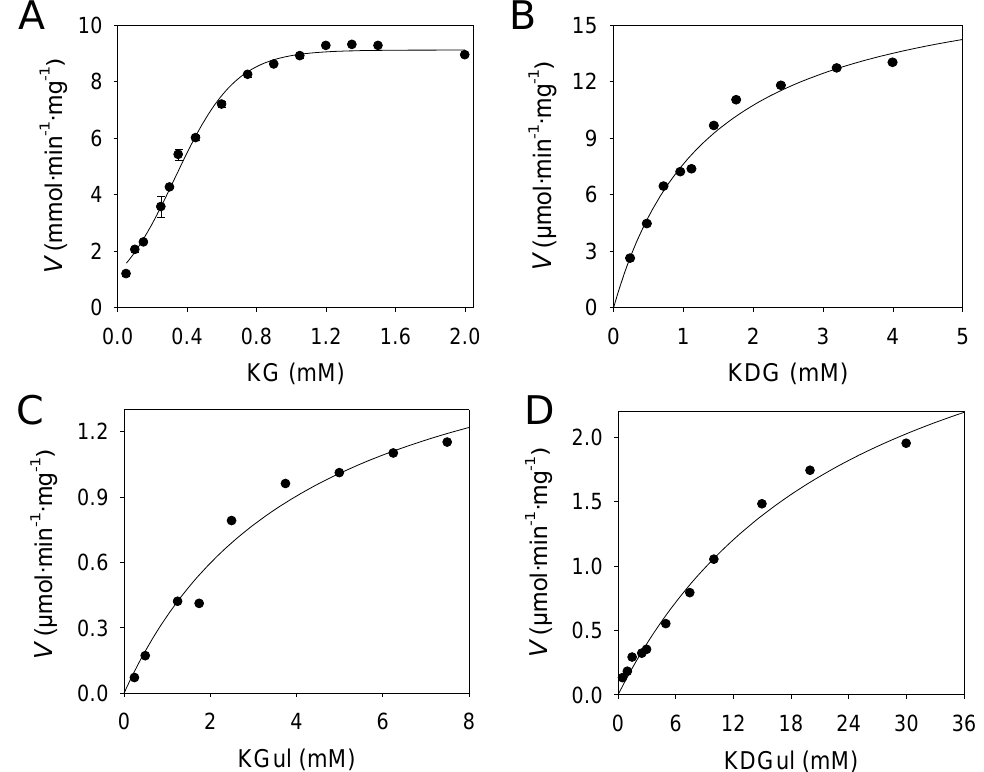
Figure 2. Substrate kinetics of kinase activity for KGUK from C. necator for different substrates (at 25 °C). Activity of purified KGUK was measured at increasing concentrations of the acceptor substrates 2-keto-D-gluconate (KG) ( A ), 2-keto-3-deoxygluconate (KDG) ( B ), 2-ketogulonate (KGul) ( C ), and 2-keto-3-deoxygulonate (KDGul) ( D ), maintaining a constant excess of ATP (1.25 mM) and Mg 2+ (5 mM). Final concentration of pure KGUK was customized in each kinetic experiment to optimize the activity measurement: 2.5 μ g/mL of purified enzyme for KG kinetics ( A ), 1.5 μ g/mL for KDG assays ( B ), and 3.4 μ g/mL for KGul and KDGul experiments ( C and D ).